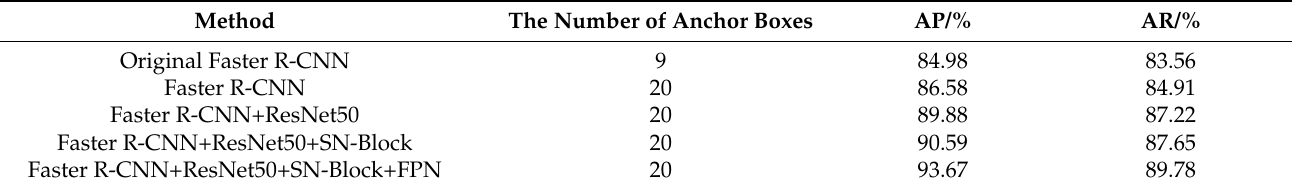
Table 2. Comparison of detect results under different improvement